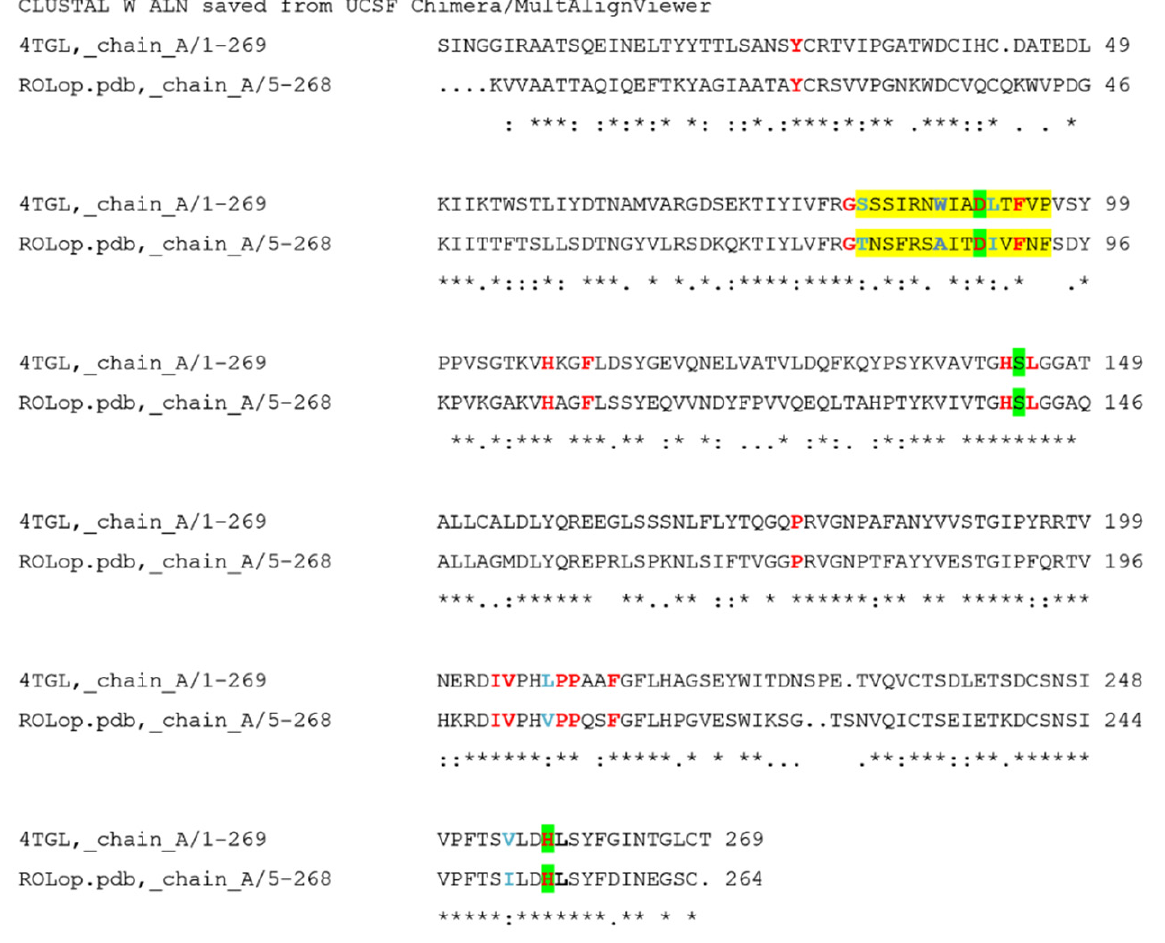
Figure 3. Structure based sequence alignment of 4TGL (RML) and ROLop. The catalytic triad residues are highlighted in green and the residues constructing the lid region are highlighted in yellow. Residues marked in red are located in the active site, i.e., potentially substrate interacting, and are identical in both sequences. Residues marked in blue are potential substrate interacting residues, at corresponding positions in the two structures, but are not completely conserved. Most of the residues, interacting with RML and ROL are displaying similar chemical properties (red and blue), except W88 in RML which at the identical position is A89 in ROL (also marked in blue).